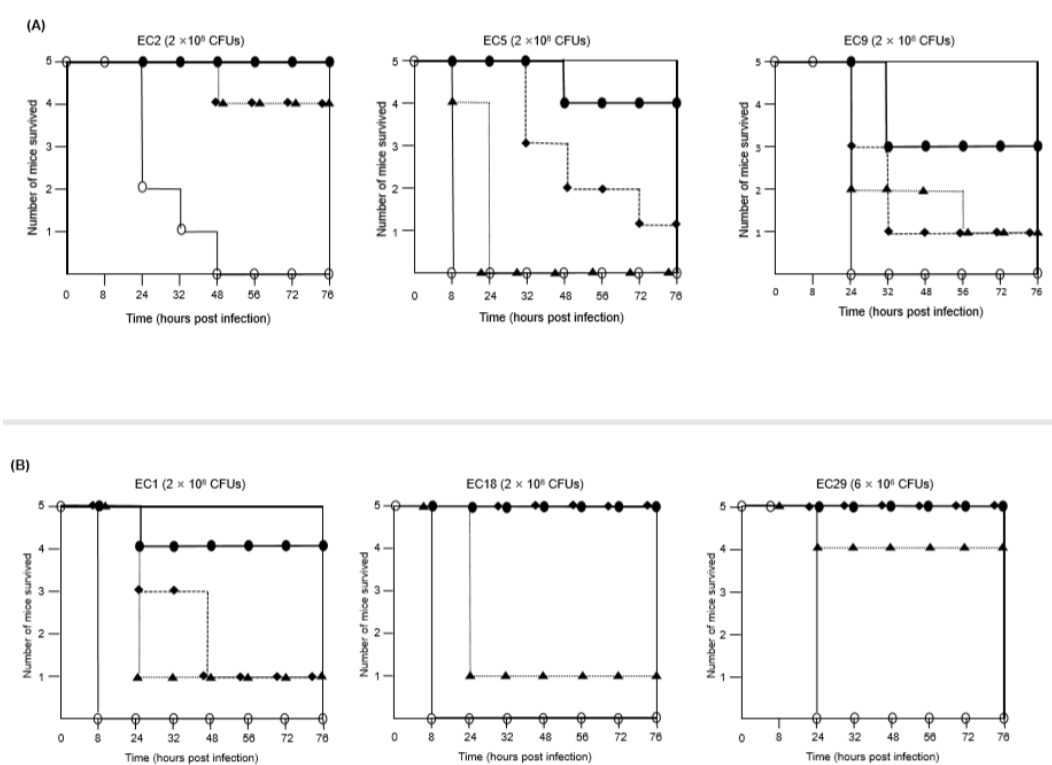
Figure 1. Treatment of mice infected with E. coli isolates. Mice were infected with E. coli isolates intraperitoneally. Bacterial inoculum size is indicated in parentheses. After 30 min, the mice received antimicrobial agents intramuscularly. ( A ) Mice infected with E. coli isolates (EC2, EC5, and EC9) were treated with PBS ( ○ ), FFL ( ▲ , 20 mg/kg), AMK ( ◆ , 10 mg/kg), or FFL (20 mg/kg)/AMK ( ● , 10 mg/kg). ( B ) Mice infected with E. coli isolates (EC1, EC18, and EC29) were treated with PBS ( ○ ), FFL ( ▲ , 20 mg/kg), GEN ( ◆ , 20 mg/kg), or FFL (20 mg/kg)/GEN ( ● , 20 mg/kg).